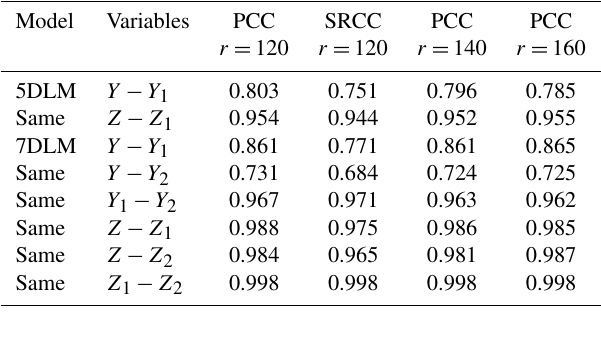
Table 2. The Pearson correlation coefficients (PCC) and the Spear- man Rank correlation coefficient (SRCC) between two different variables from the primary, secondary, and tertiary modes in the 5DLM or 7DLM. For the PCCs, results obtained from three cases with r = 120, 140 and 160 are provided. For the SRCCs, only re- sults from the case with r = 120 are listed. Model Variables